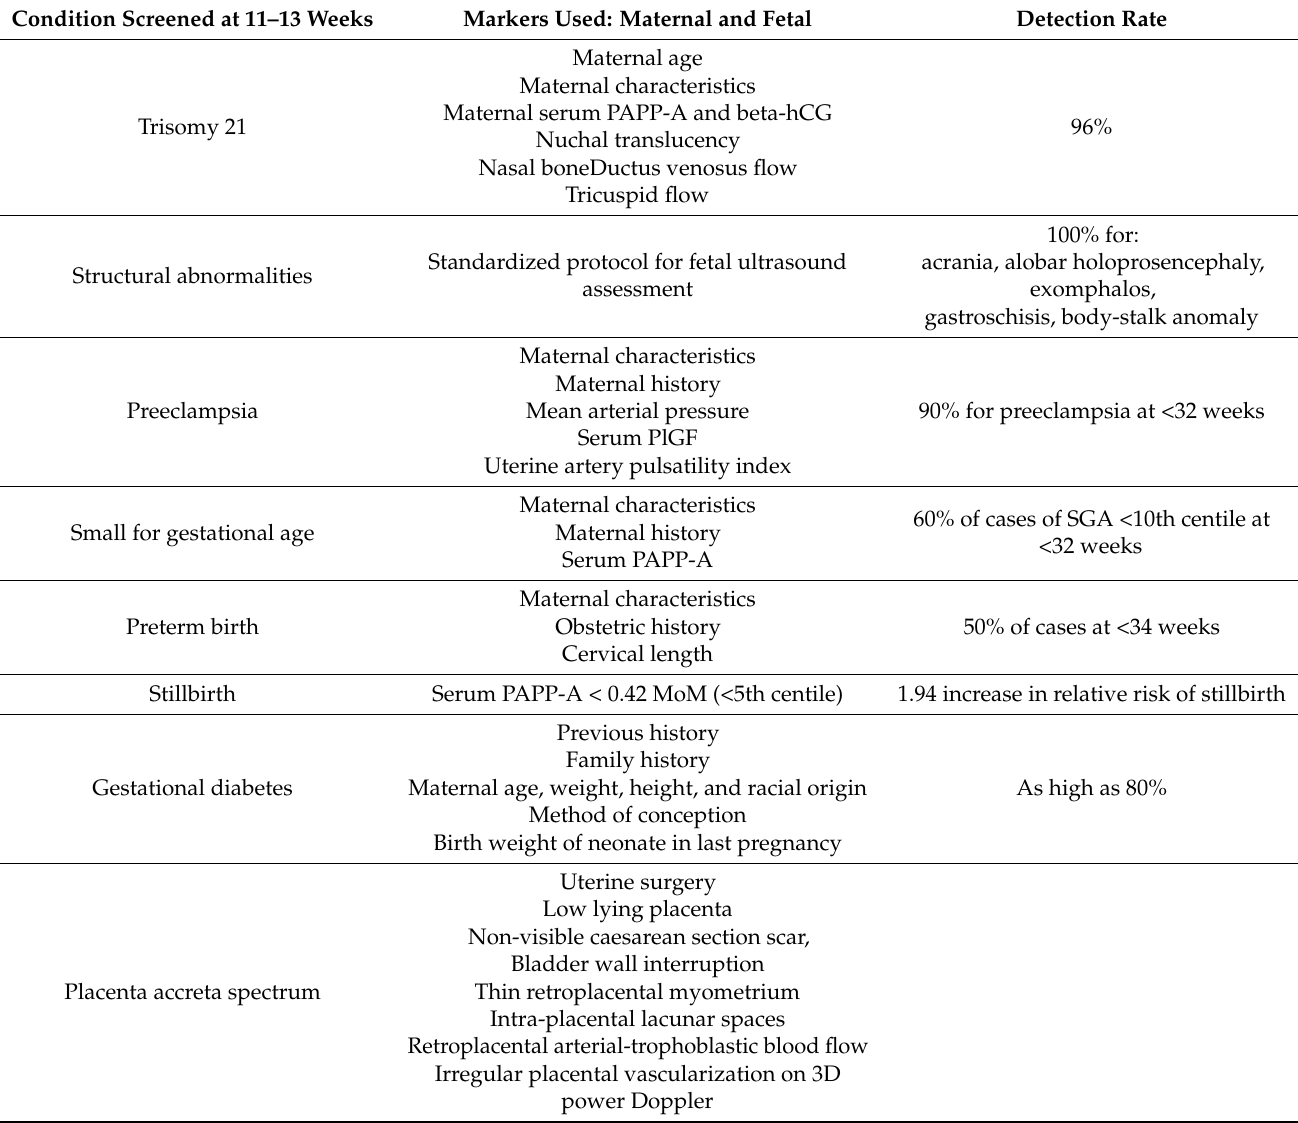
Table 2. Summary of methods used for screening at 11–13 weeks for pregnancy